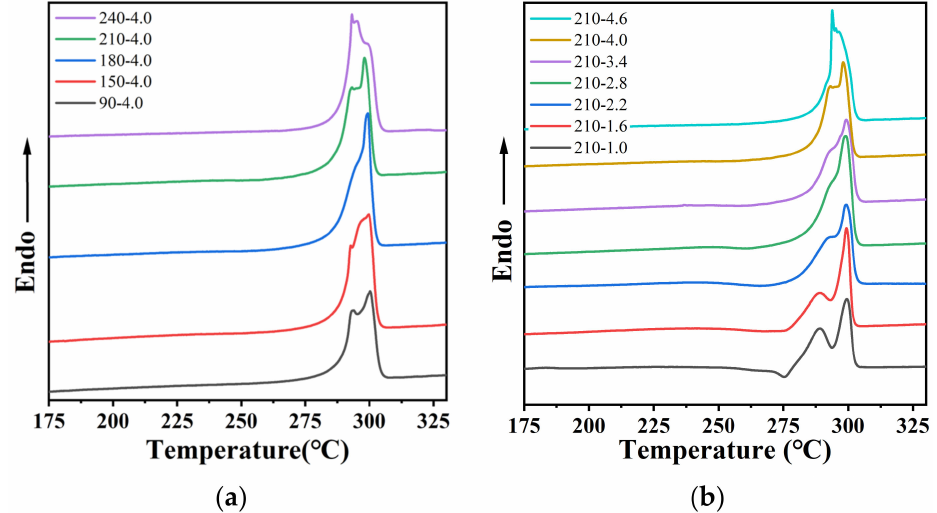
Figure 4. DSC melting curves of PA12T samples with ( a ) different stretching temperatures at stretch- ing ratio of 4; ( b ) different stretching ratios at stretching temperature of 210 ◦